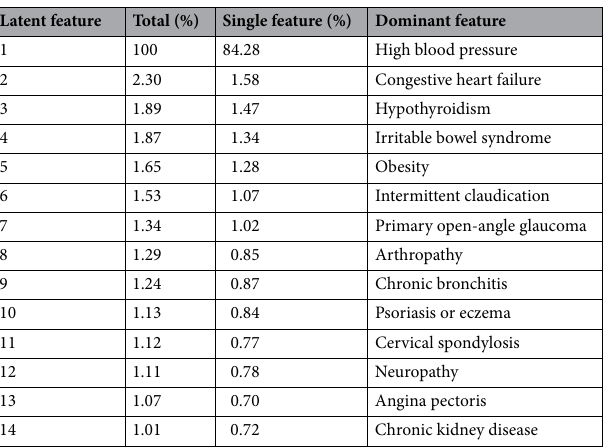
Table 3. Probabilities (%) of possessing at least one latent feature or a single feature. The total column represents the total number of patients with the individual latent feature. While the single feature column represents the number of patients with at least that specific latent feature active. Each latent feature (LF) corresponds to a group of comorbidities. However, for each latent feature, one dominant comorbidity was identified (see Table 2).